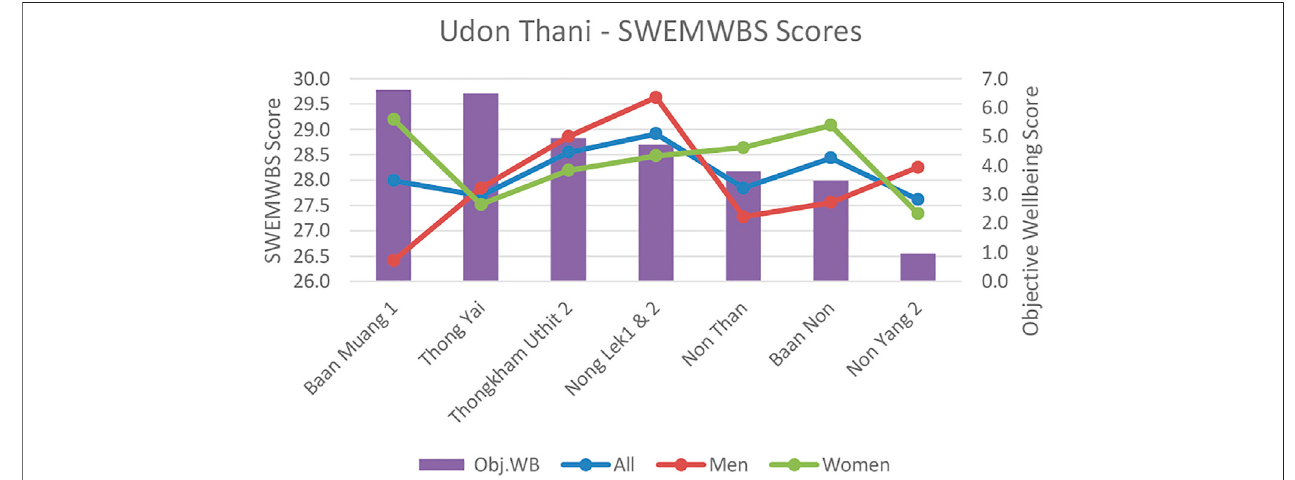
FIGURE 5 | Udon Thani Short-Warwick subjective wellbeing scores (SWEMWBS) versus objective wellbeing scores by neighbourhood.